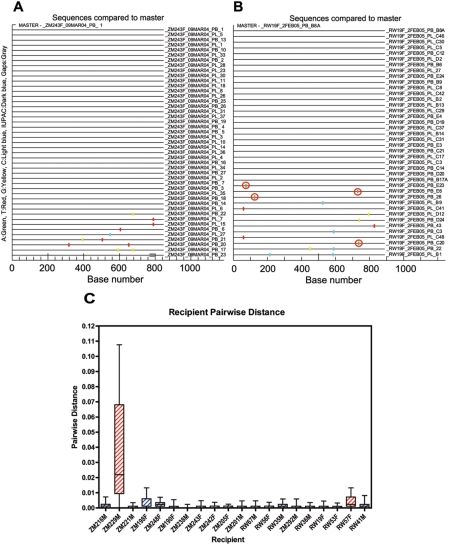
Homogenous virus population in newly infected individuals.Aligned linked recipient sequences were analyzed by the Highlighter tool (Los Alamos National Laboratory website - HIV Sequence Database), examples of output files are shown for (A) ZM243F and (B) RW19F. Tic marks indicate nucleotide differences from the indicated master sequences derived from the recipient. Nucleotide differences are color-coded and are marked according to their genetic location along the length of V1–V4. Colors are as follows: A: green, T: red, G: yellow, C: blue and gaps: gray. Tics highlighted by circles represent G to A changes in a sequence consistent with an APOBEC3G/F signature. (C) Box plots were generated using the pairwise distances calculated for individual linked recipients. Horizontal lines within box plots indicate median pairwise distance values for each linked recipient. Red boxes indicate individuals infected by multiple genetic variants.